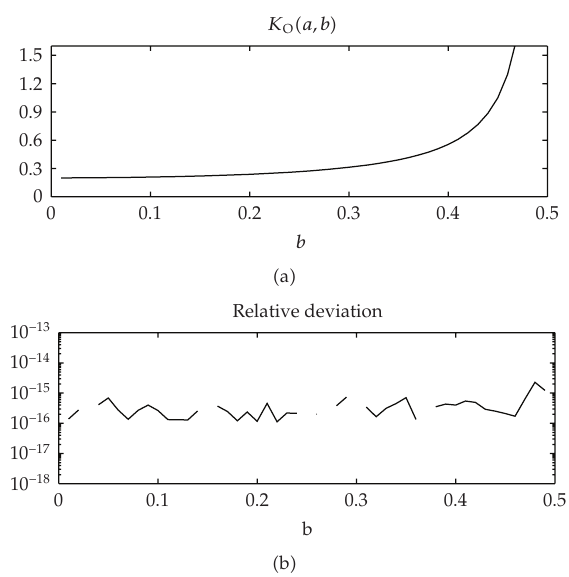
Figure 13: Comparison of the direct series evaluation (cid:2) solid (cid:3) and the analytic representation (cid:2) dashed (cid:3) for the odd-order spectra K O with n (cid:6) 0, b (cid:6) 0 . 95 as the parameter b is varied. The inset shows the relative di ff erence between the direct series evaluation and the analytic